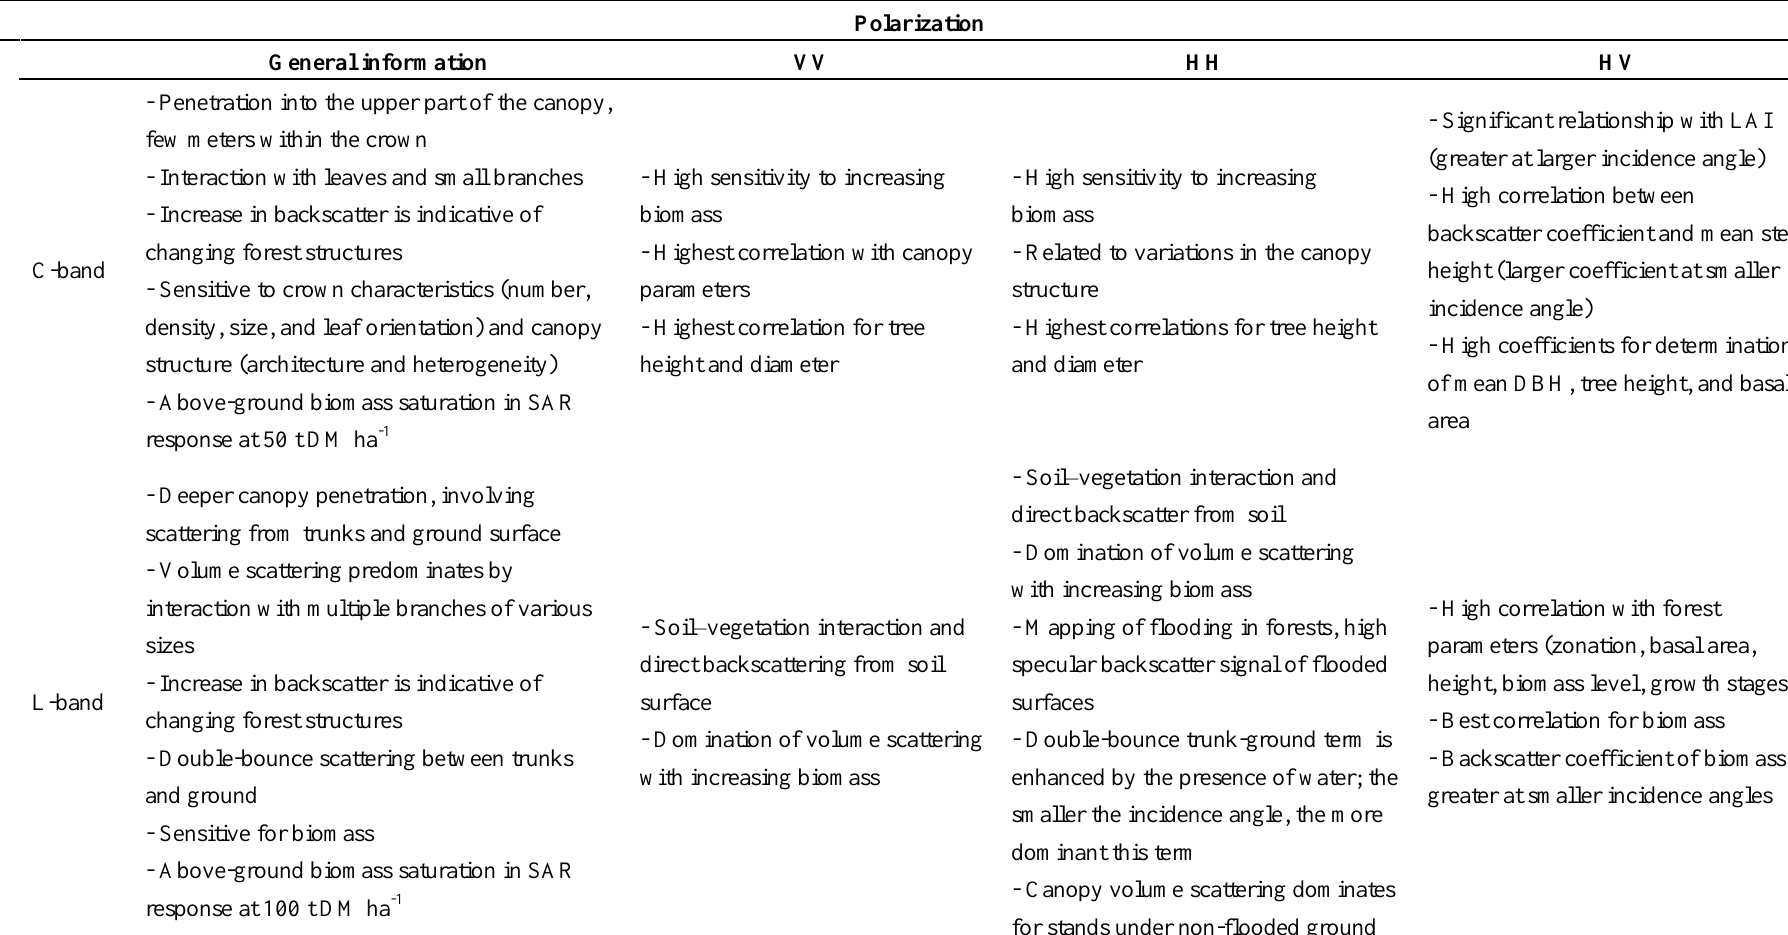
Table 1. Characteristics of the backscatter signal depending on mangrove structural components, biomass, and forest